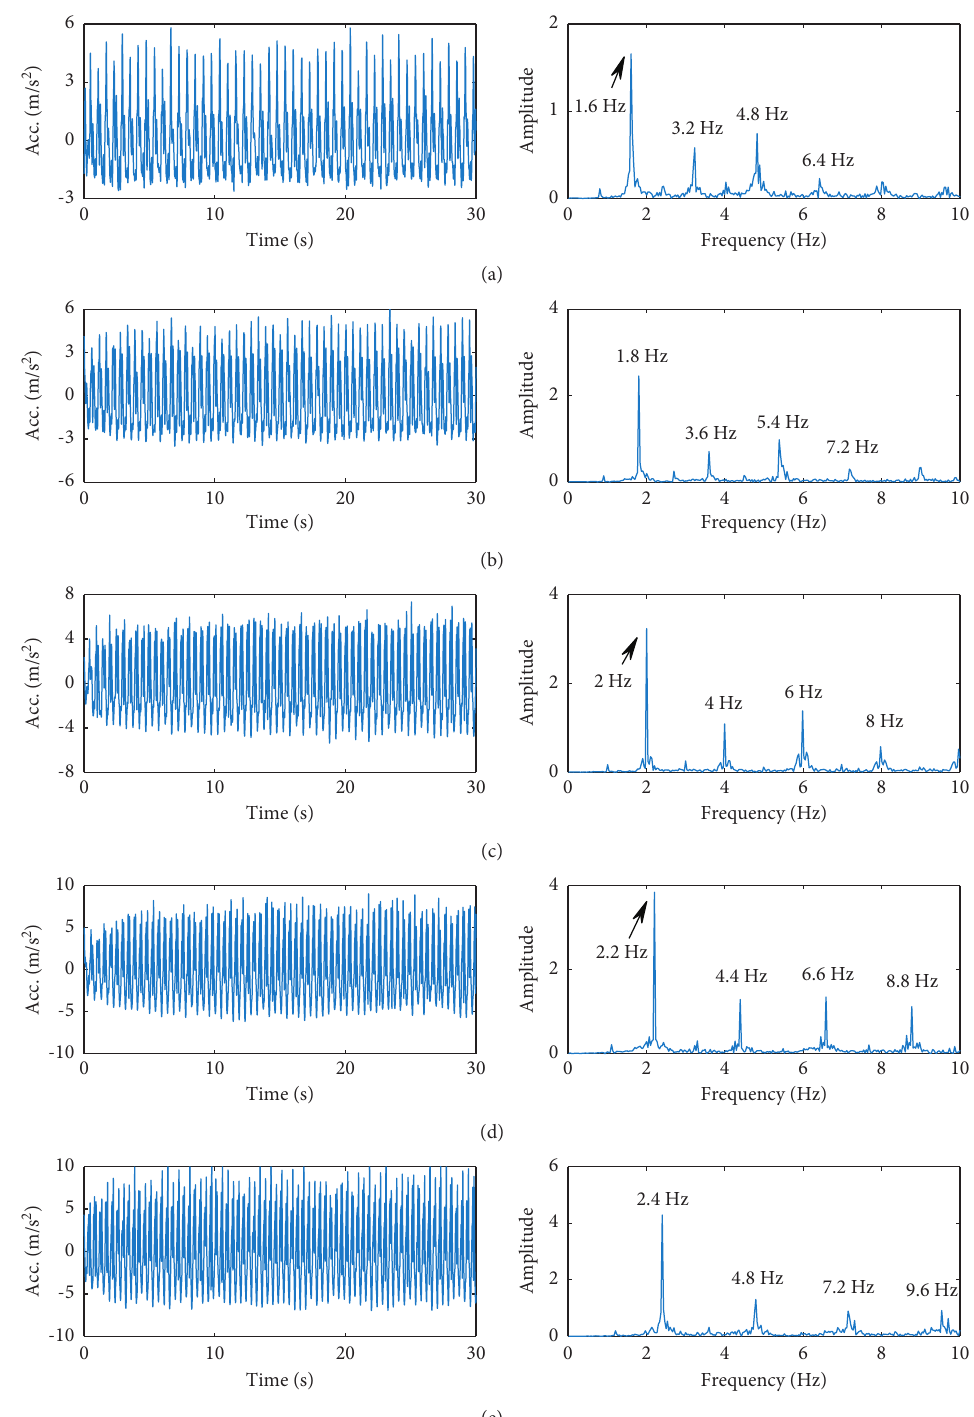
Figure 18: Vertical body acceleration for a single-person walking at step frequencies of (a) 1.6Hz, (b) 1.8Hz, (c) 2.0Hz, (d) 2.2Hz, and (e) 2.4Hz in time and frequency